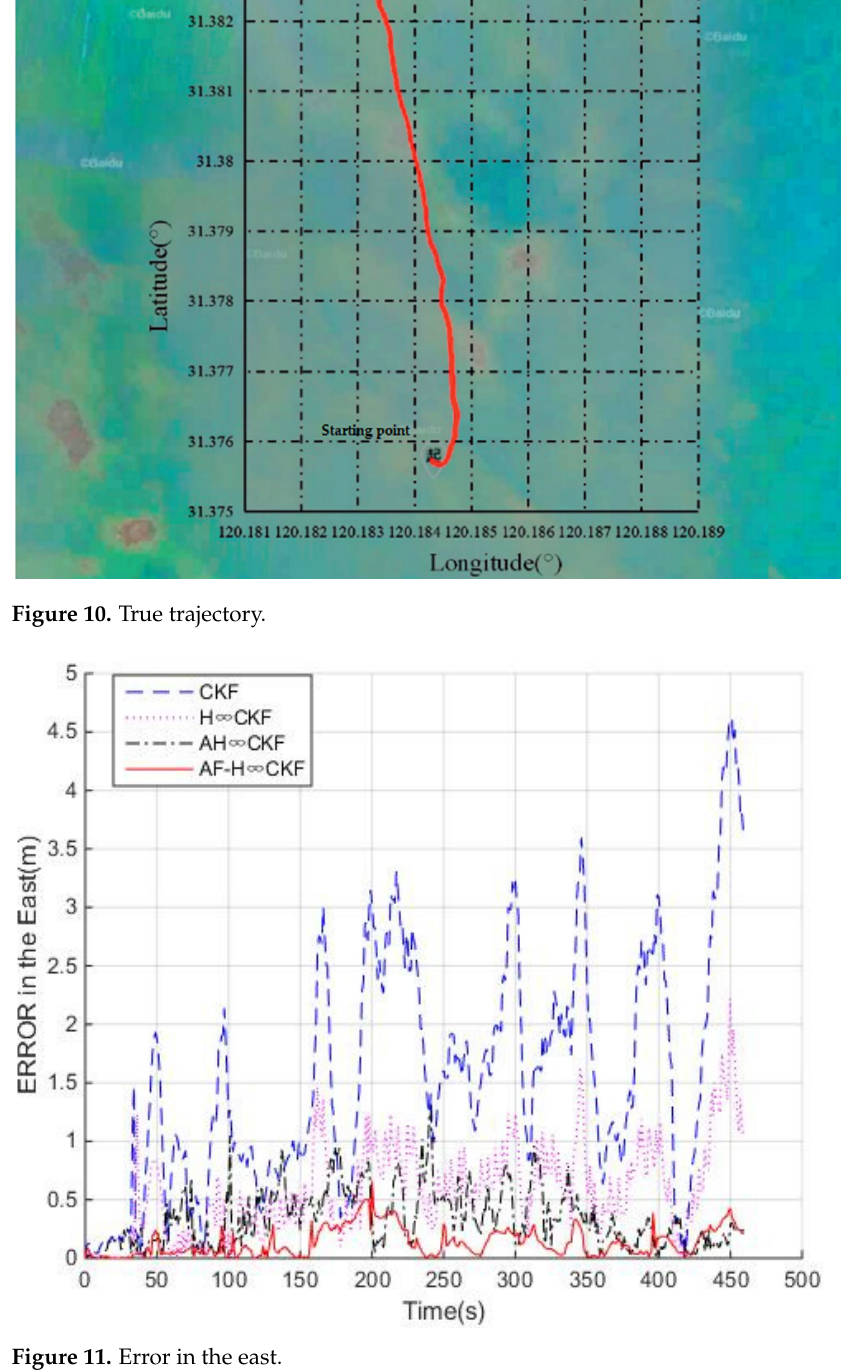
Figure 11. Error in the east.